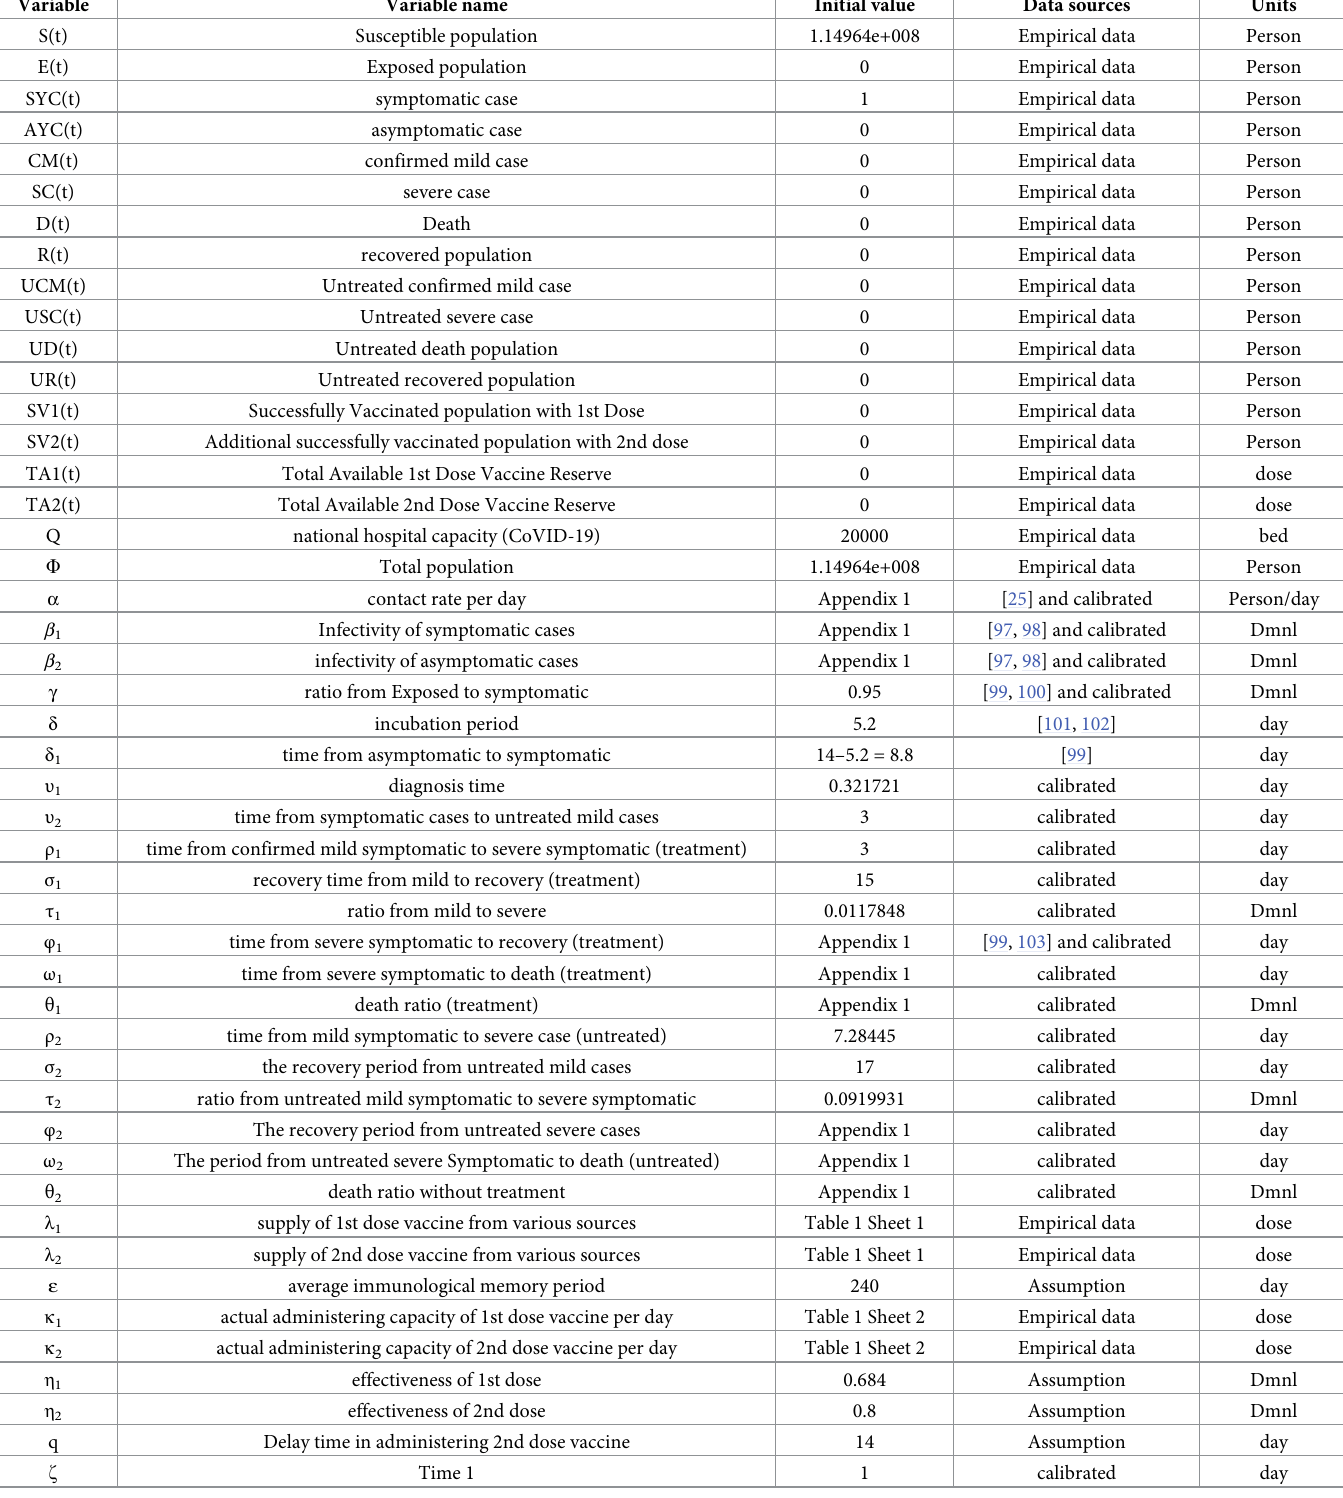
Table 1. Model calibration results.